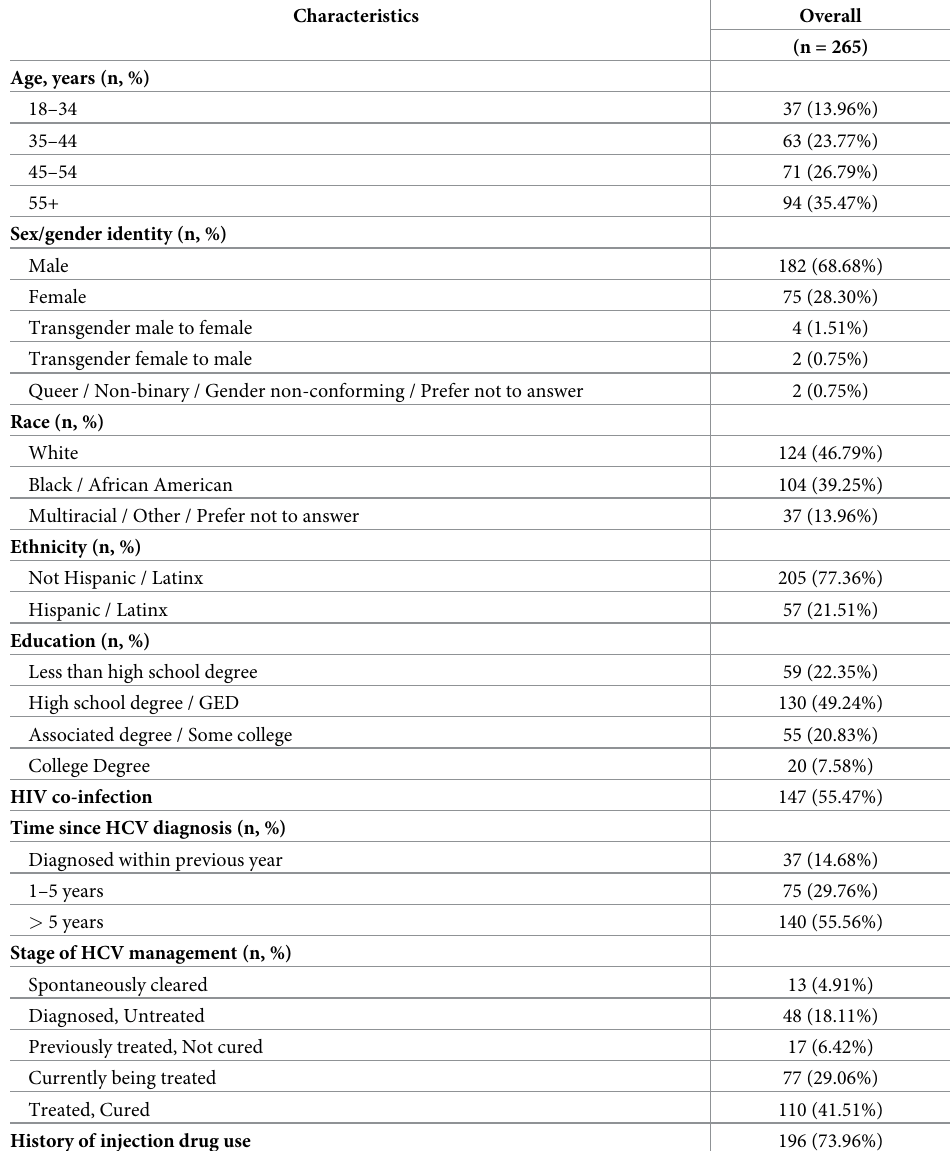
Table 1. Baseline characteristics of participants.